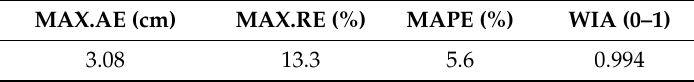
Figure 7. Error distribution of prediction results. Table 3. Evaluation of the prediction method and